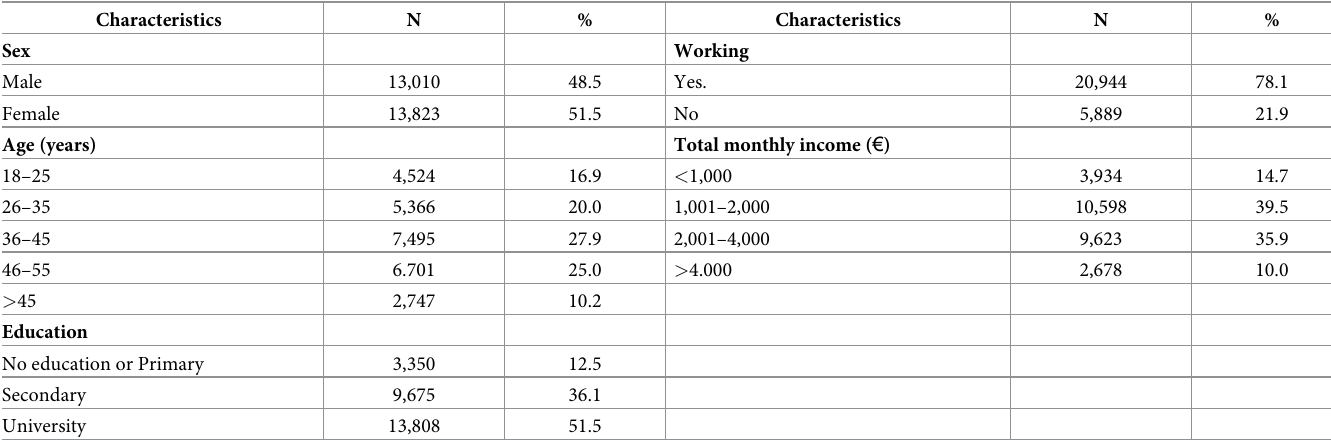
Table 2. Sample profile of CTS active